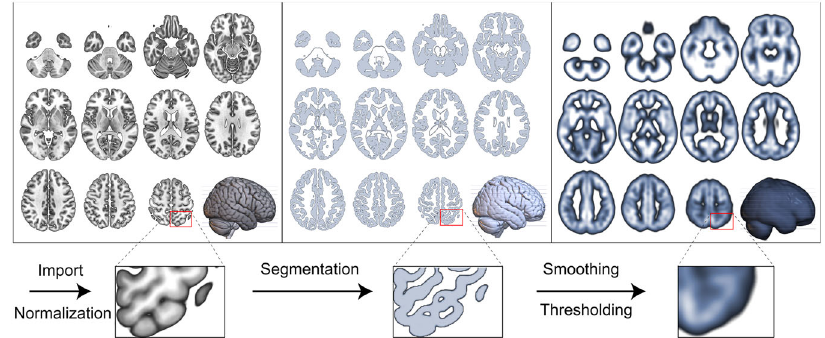
Fig. 2 Image preprocessing pipeline. Image preprocessing pipeline was used to normalize the images to the MNI152 standard space, segment the brain into probabilistic maps of gray matter, which were subsequently smoothed to reduce interindividual sulci and gyri positioning.